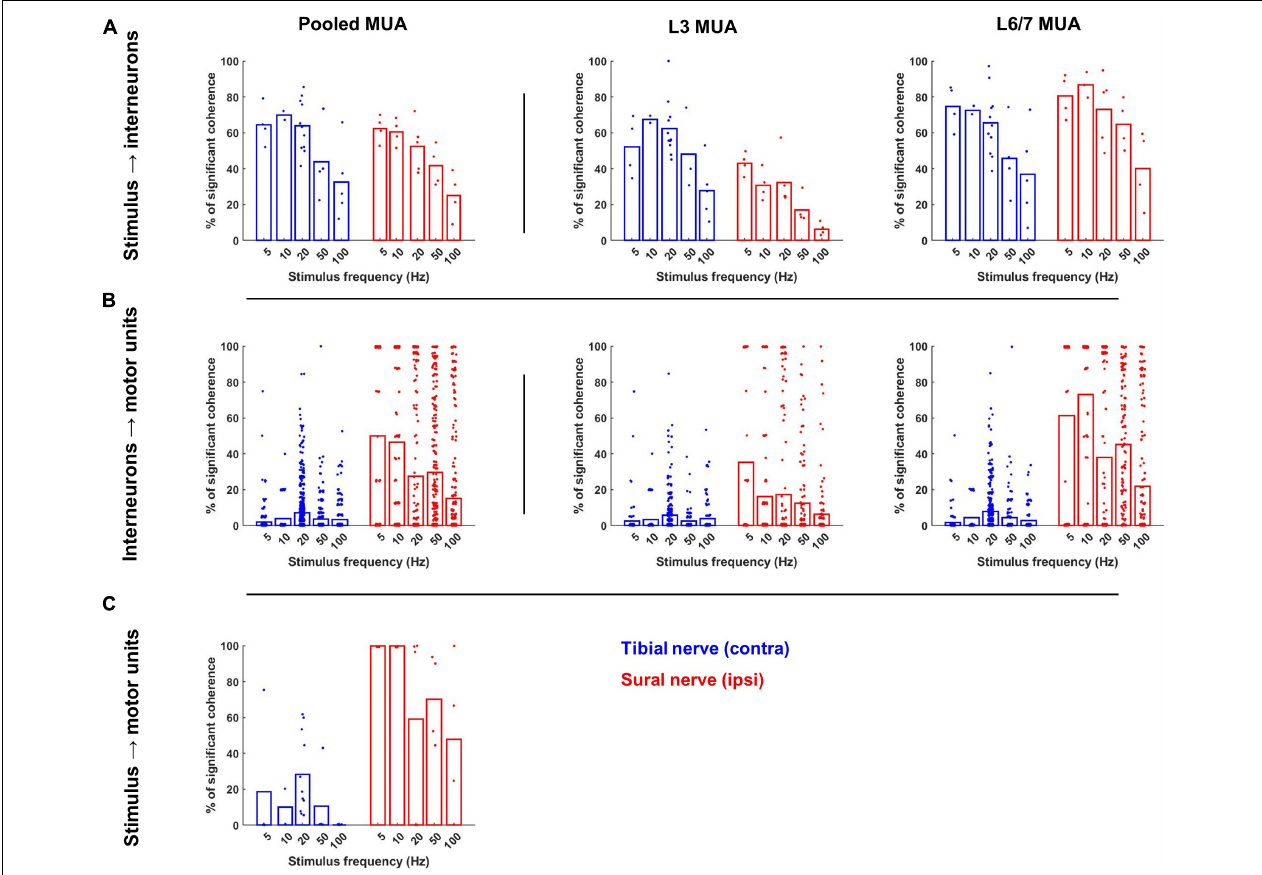
FIGURE 6 | Occurrence of significant coherence during contralateral tibial and ipsilateral sural nerve stimulation across frequencies. (A) Percentage of interneurons during each trial that were significantly cohered to the stimulus pulse train. The leftmost plot displays these percentage values for the entire interneuron population recorded during each trial, while the middle and right plots display the percentage of interneurons from each recording site that were cohered to the stimulus. (B) Percentage of the motor unit population that were significantly cohered to each interneuron during each trial across the entire population of interneurons (left) and population of interneurons at each recording site (right). (C) Percentage of motor pool that was significantly cohered to the stimulus pulse train. Bars represent the average percentage of significant coherence; individual data points have been jittered with uniformly distributed noise to minimize